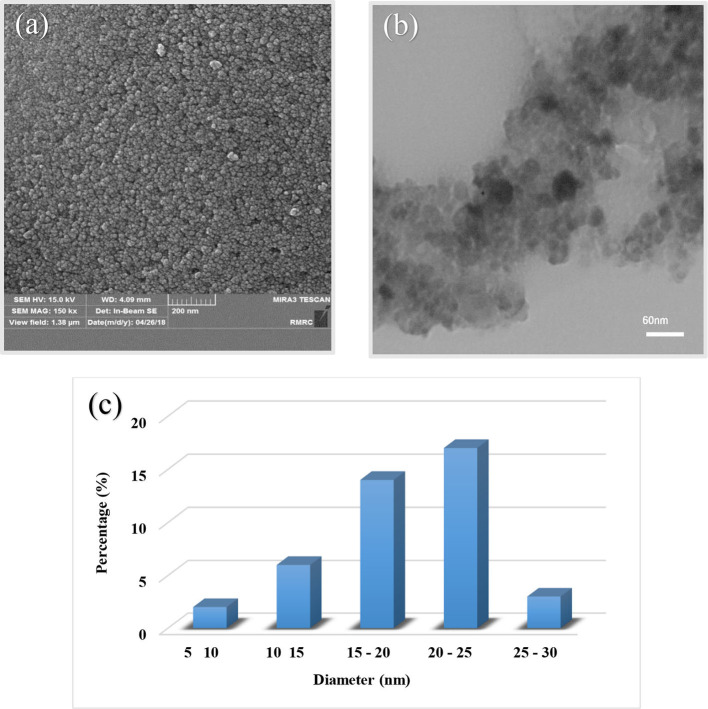
SEM (a) and TEM (b) images of Fe3O4@PVA-Cu nanoparticles and size distribution of nanoparticles chart (c).